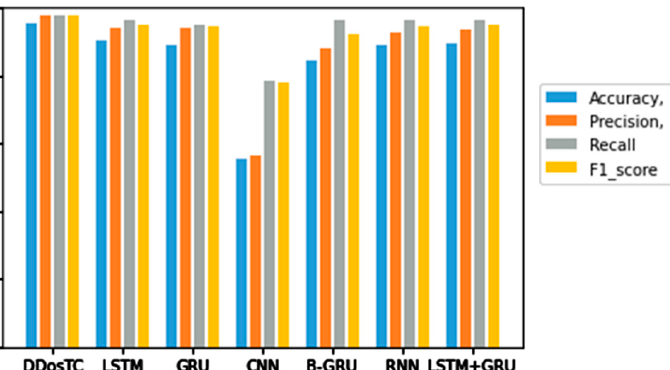
Figure 10. Accuracy, precision, recall rate, and F1 score results for DDosTC and other test methods with a training set/test set ratio of with a training set/test set ratio of 7:3.